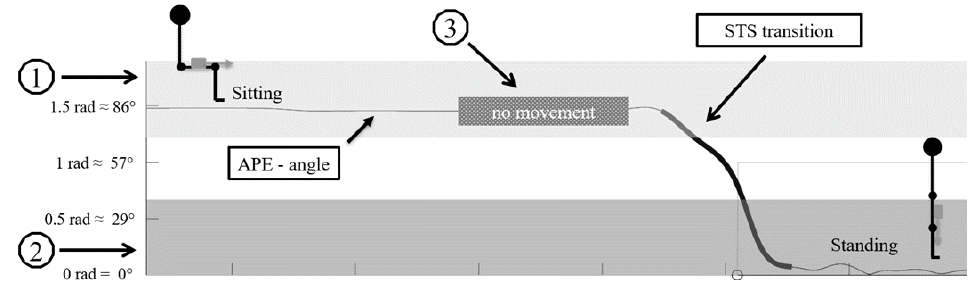
Figure 1. STS transition detection conditions: (1) STS start position> 65 degrees; (2) STS start position> 35 degrees; (3) no motion before STS transition (results of MAD variation <0.02).